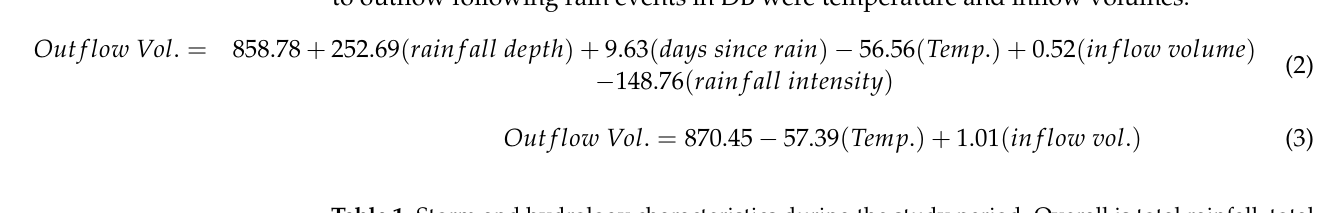
Table 1. Storm and hydrology characteristics during the study period. Overall is total rainfall, total inflow, total outflow, mean volume reduction, mean temperature, mean rain intensity, and mean days since last